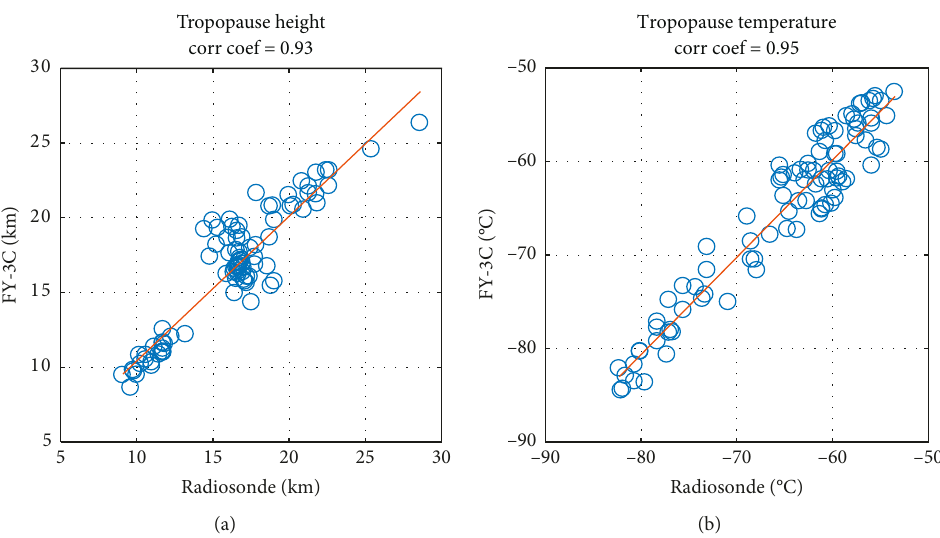
Figure 11: Comparison of the tropopause height (a) and temperature (b) obtained from FY-3C occultation data and radiosonde